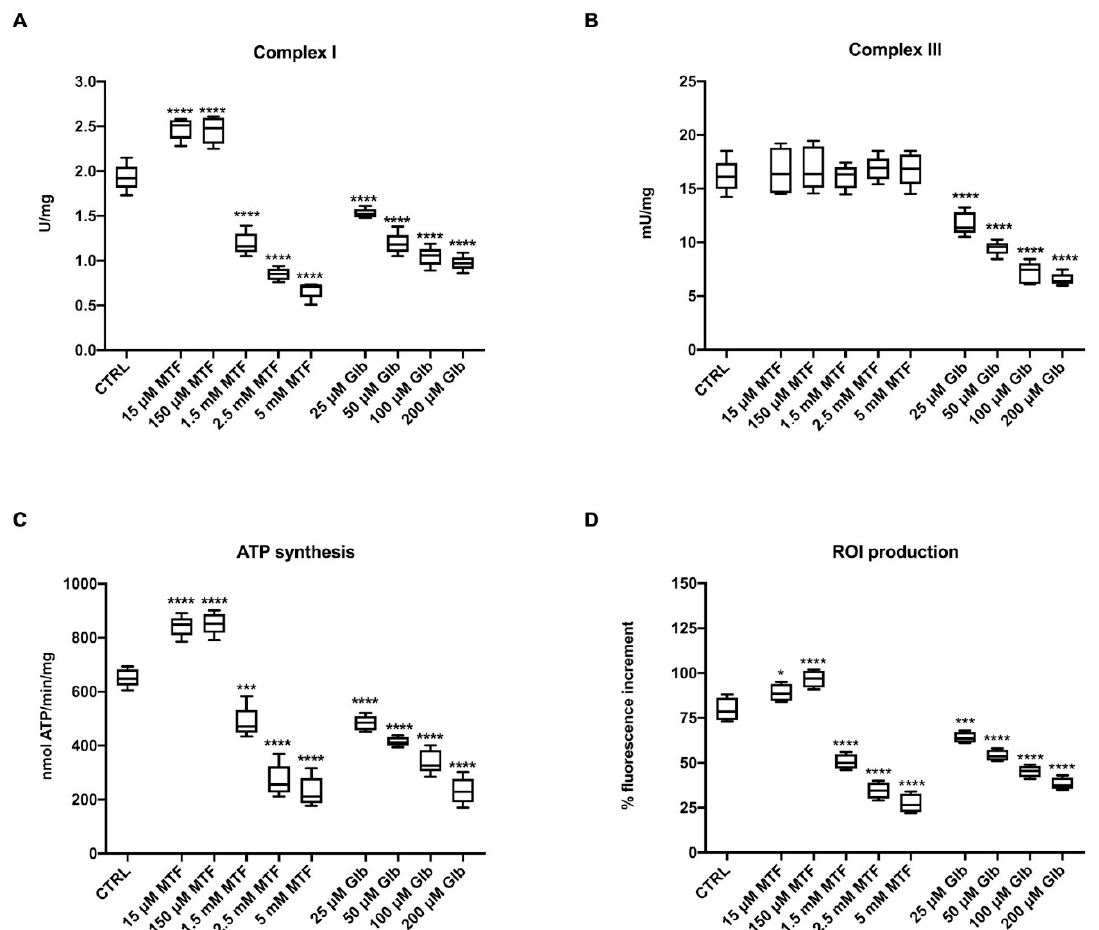
Figure 2. Effect of metformin (MTF) and glibenclamide (GLB) on the aerobic metabolism and reactive oxygen intermediates (ROI) production in rod OS; the figure reports the e ff ect of 15 µ M, 150 µ M, 1.5 mM, 2.5 mM, 5 mM MTF and 25, 50, 100, 200 µ M GLB on the aerobic metabolism in rod OS. ( A ) Complex I activity, expressed as U / mg of total protein. ( B ) Complex III activity, expressed as mU / mg of total protein. ( C ) ATP synthesis trough F o -F 1 ATP synthase expressed as nmol of ATP produced / min / mg of total protein. ( D ) ROI production in rod OS, exposed to light. Data are from n = 5 independent experiments; *, ***, or **** indicate a significant di ff erence for p < 0.05, 0.001, or 0.0001, respectively, between treated and untreated samples (CTRL).